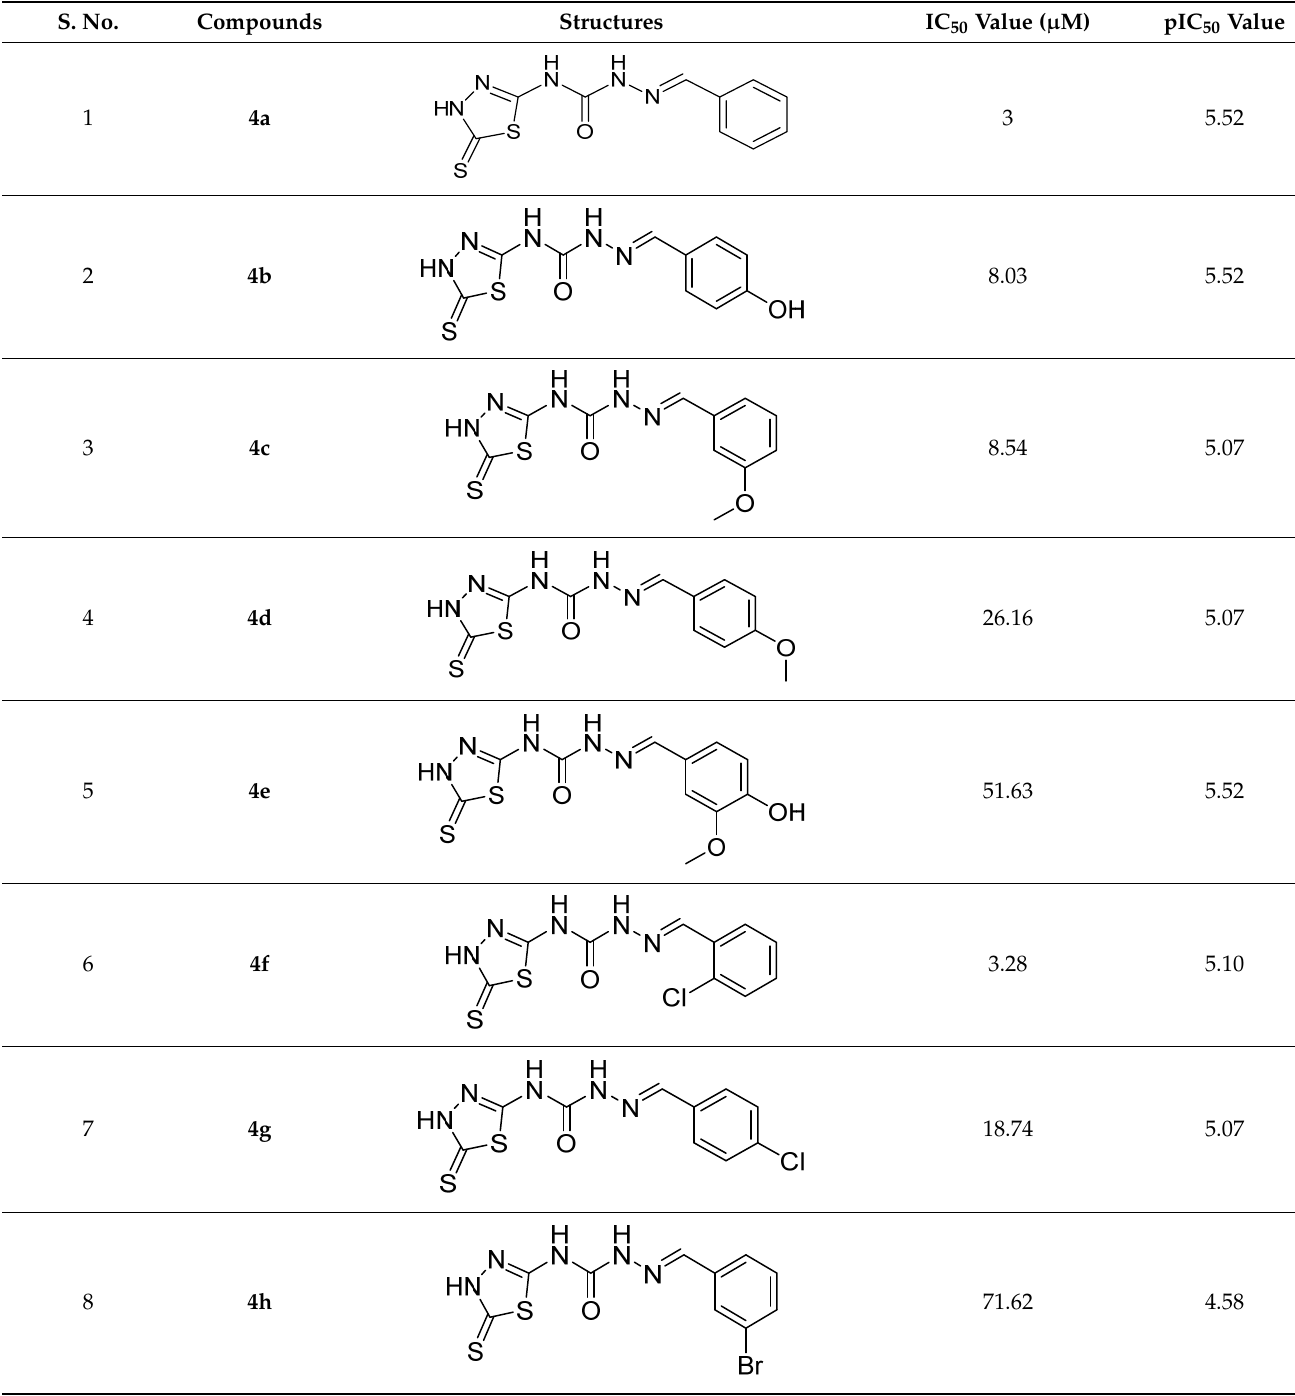
Figure 1. The schematic workflow of 3D QSAR, pharmacophore model, docking, and virtual screen- ing performed in the present study. Table 1. Compounds taken in QSAR study with CA inhibitory activity (IC 50 and pIC 50 value) [21]. S. No.